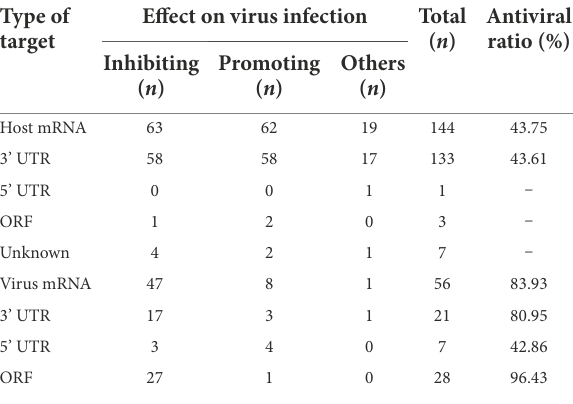
TABLE 1 The reported effects of miRNAs on viruses at different target